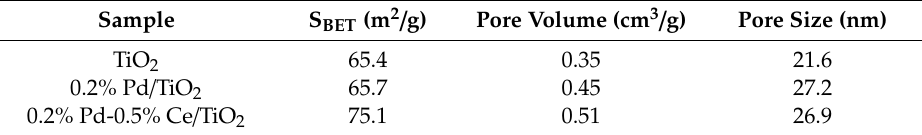
Table 2. BET surface area and pore structure of